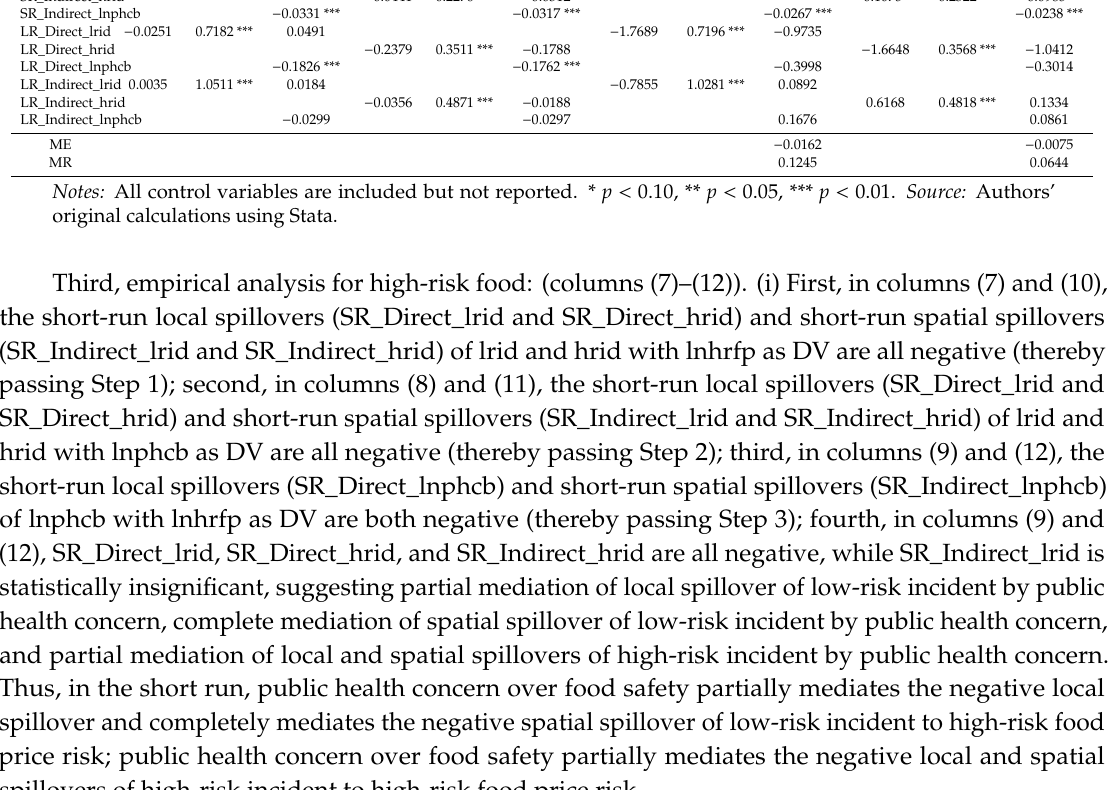
e ff ect (ME) and ratio of mediation e ff ect to total e ff ect (MR) using the main coe ffi cients